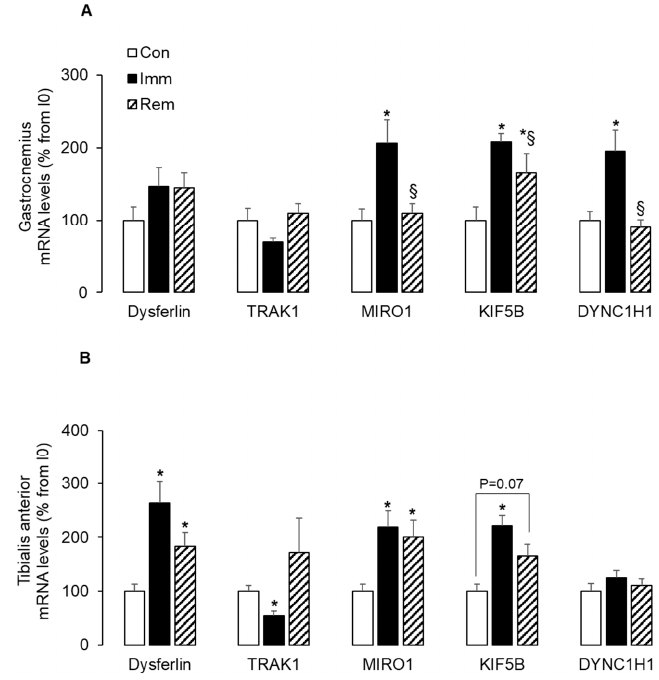
Figure 3. The expression of microtubules-based mitochondria trafficking markers increased during remobilization. The mRNA levels for Dysferlin, TRAK1, MIRO1, the kinesin KIF5B, and the dynein DYNC1H11 were measured in the GA ( A ) and the TA ( B ) by RTqPCR and were normalized using 18S rRNA. Data were expressed as % from the Con group. Statistical di ff erences were assessed by ANOVA, as described in Materials and Methods. * p < 0.05 vs. Con, § p < 0.05 vs. Imm; Con, non-immobilized rats; Imm, immobilized; Rem,